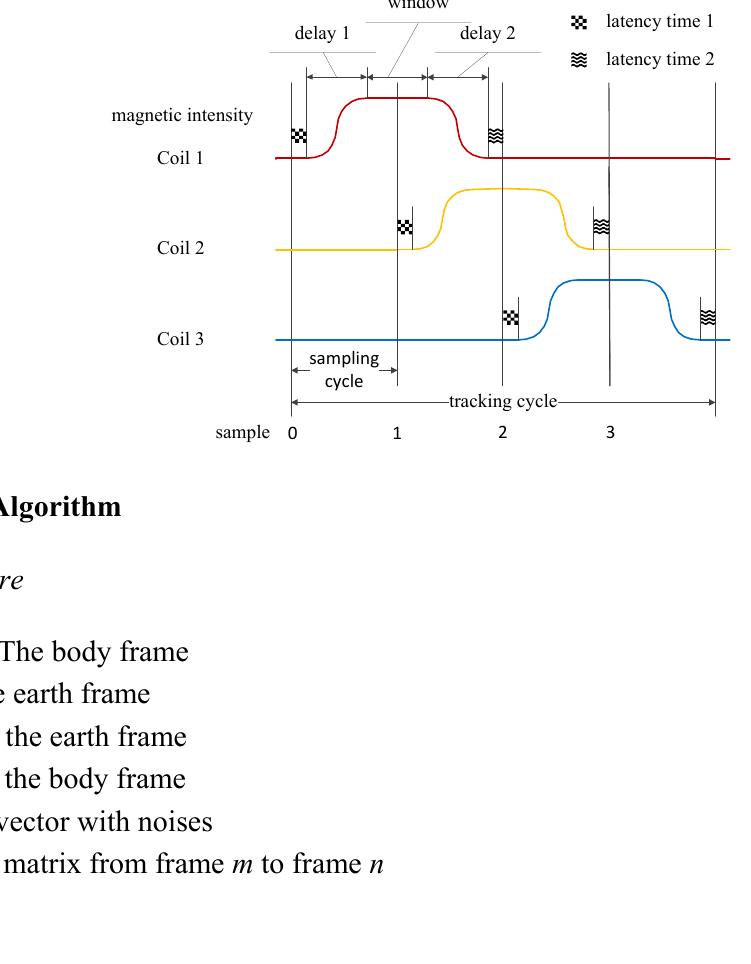
Figure 4. The working sequence of the ultrasonic endoscope tracking